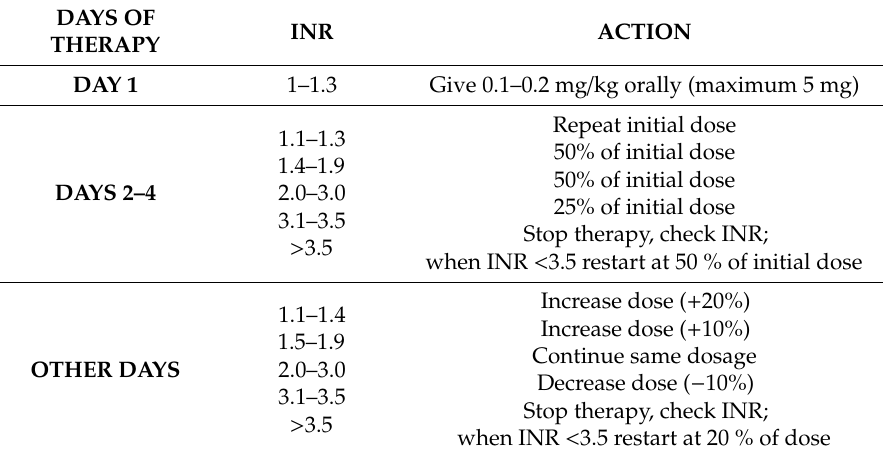
Table 2. Adjustment of VKA dose according to INR modified by